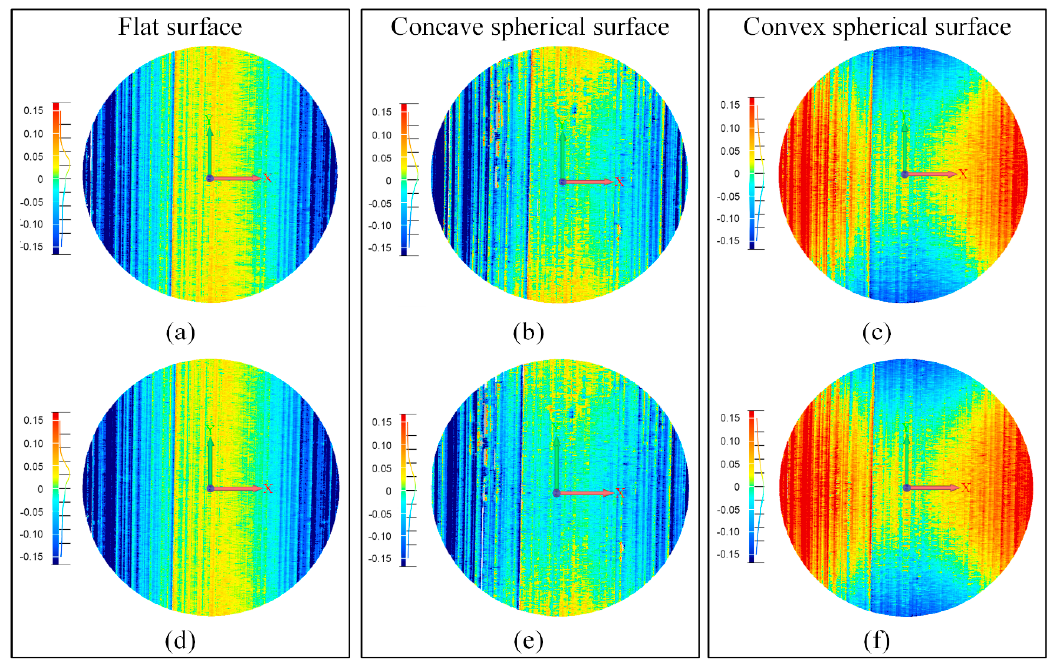
Figure 12. Color maps of the deviations from each measured point to the best-fit surfaces. ( a – c ) Color maps of surfaces with a speed of 60 mm/s; and ( d – f ) color maps of surfaces with a speed of 30 mm/s.